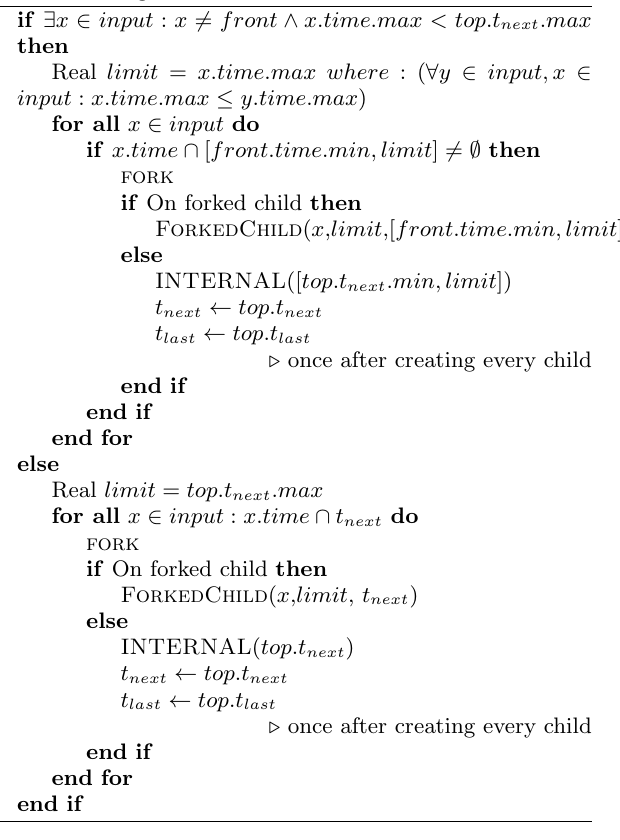
Algorithm 5 Abstract Root-Coordinator handling of events colliding inside the scheduled